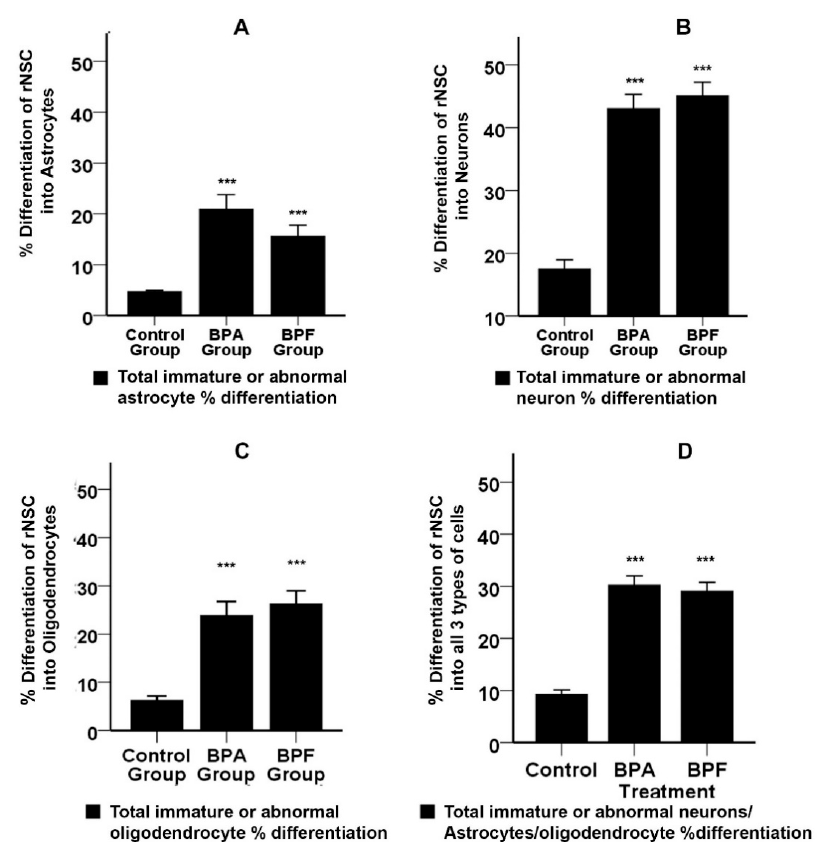
Figure 6. Effects of BPA or BPF on percentage differentiation of rNSCs into total immature or abnormal astrocytes, neurons, and oligodendrocytes as whole groups (pooled concentration-response- data). The %differentiation was enumerated as an index of the differentiation process of rNSCs into immature or abnormal ( A ) astrocyte, ( B ) neurons, and ( C ) oligodendrocytes ( D ) overall effects of BPA or BPF on all 3-types of cells (pooled immature or abnormal astrocytes, neurons, oligodendrocytes), respectively. Differentiated astrocytes, neurons, and oligodendrocytes visualized by cell-specific protein-marker GFAP, MAP2, and mGalc, respectively. Morphology with neurites in fluorescent, DAPI, and phase contrast superimposed images were used to quantify the immature or abnormal cells of each cell category. Each data point represents mean ± SE; *** p < 0.001 compared with the relevant control